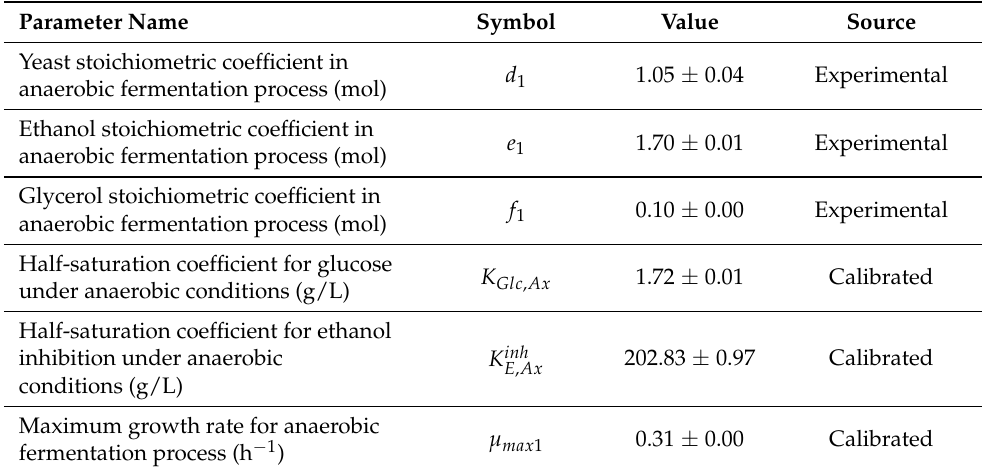
Table 3. Stoichiometry and kinetics parameters of the biological model under complete anaero- bic conditions.